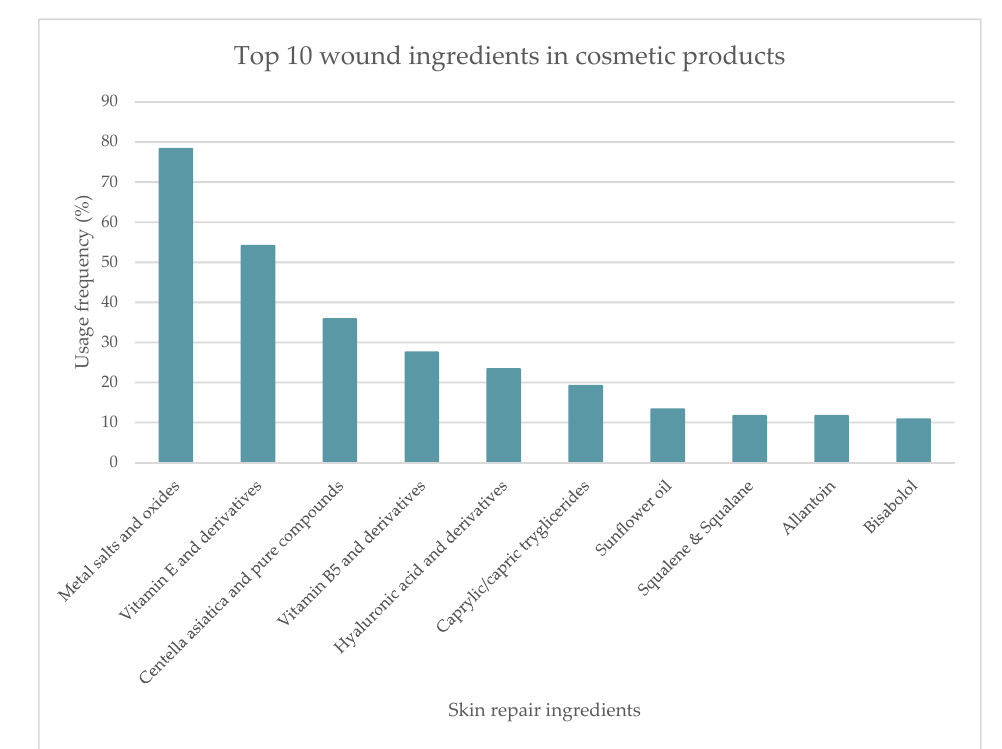
Figure 2. Usage frequency, in percentage, of the top 10 skin repair ingredients present in cosmetic products.